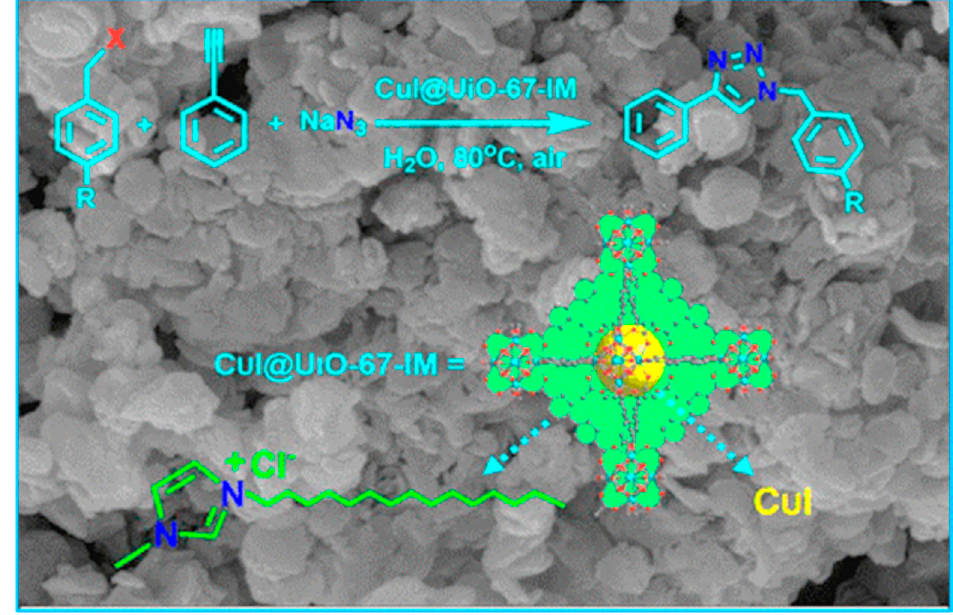
Figure 14. Copper-based MOF (CuI@UiO-67-IM) as a catalyst for alkyne azide cycloaddition reaction. Reproduced from [106] with permission from the American Chemical Society, copyright year: 2017.